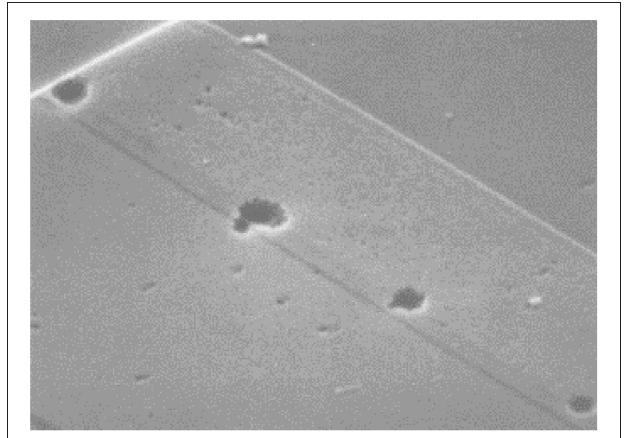
FIGURE 7 | Tungsten stud ESD failure in 45nm CMOS technology (with permission from the ESD